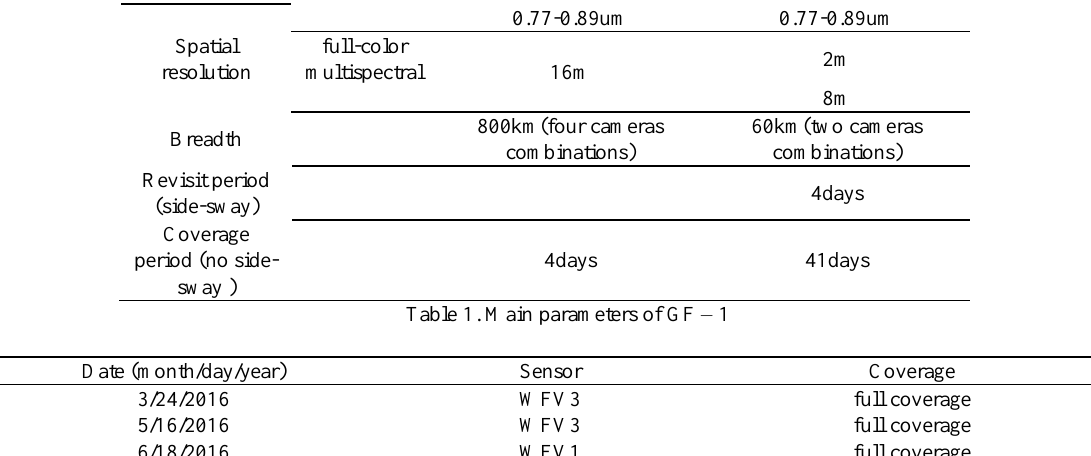
Table2. List of GF-1 data obtained in the experimental area